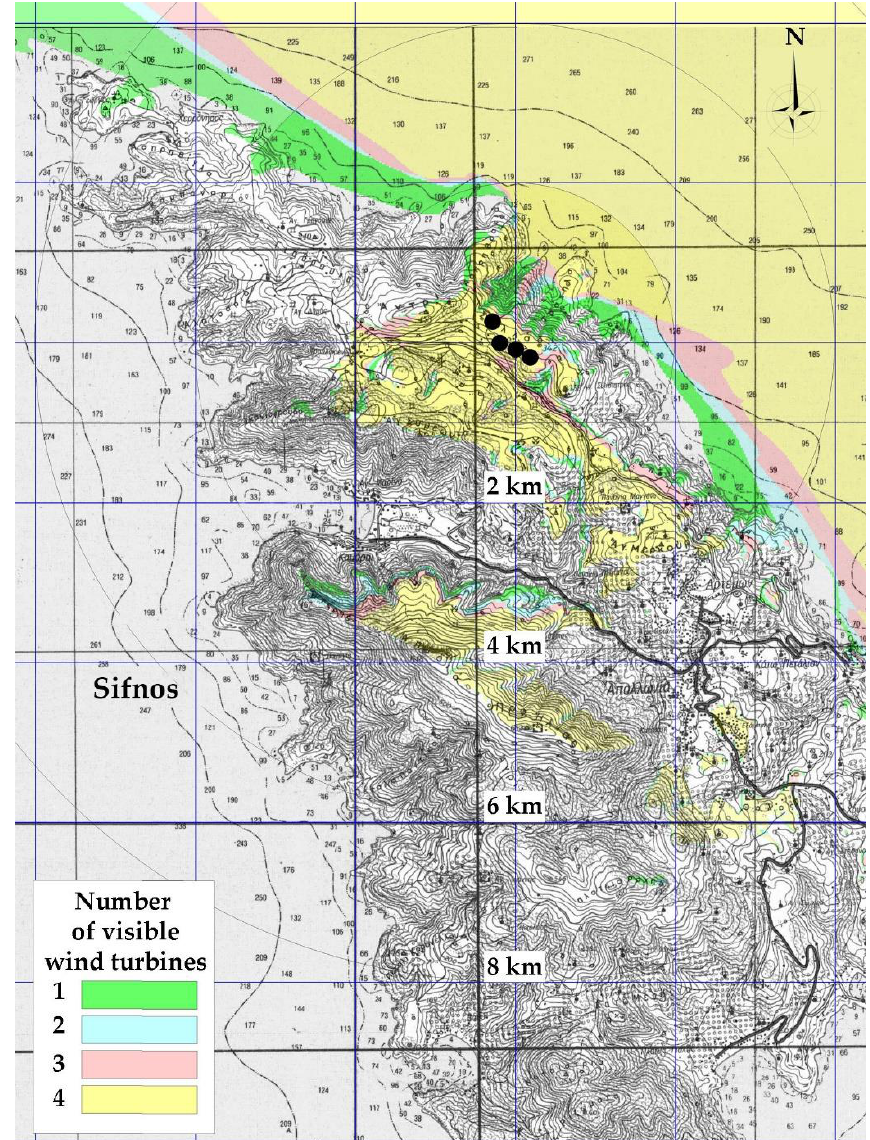
Figure 13. Zone of visual impact map of the wind park on Sifnos.